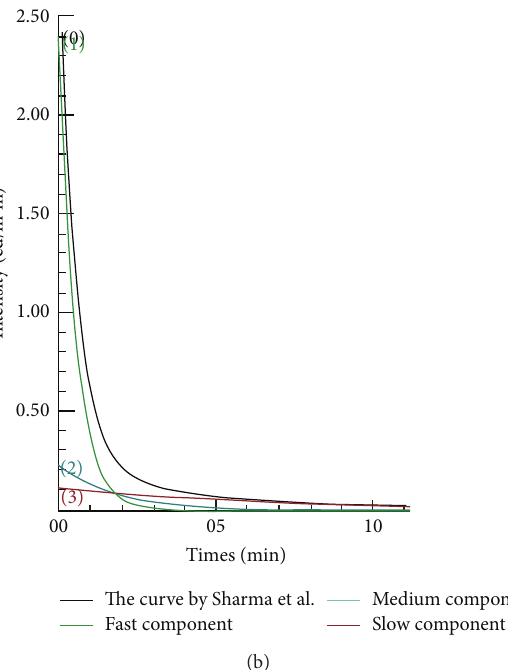
test conditions used in this study for comparison. The room temperature in the experimental tests was 25 ∘